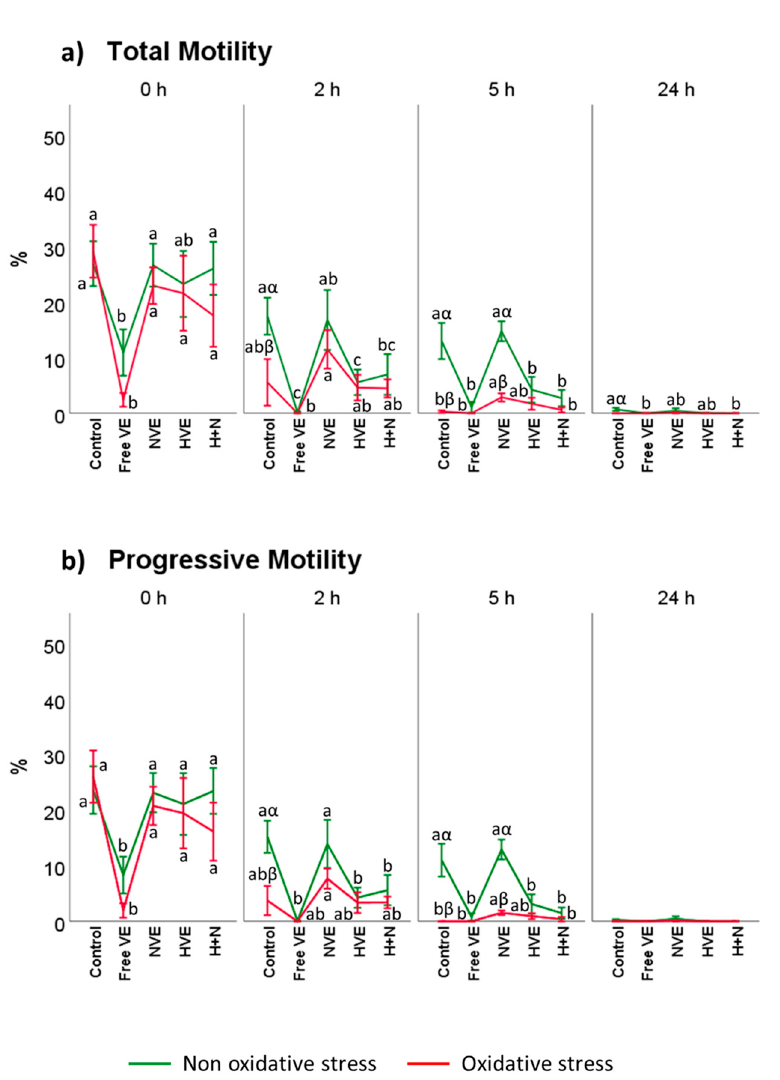
Figure 4. Vitamin E formulation effects on total ( a ) and progressive sperm motility ( b ). Plots represent the triple interaction of different vitamin E treatments × oxidative treatment × incubation time for CASA-derived variables. The various lowercase Latin letters ( p < 0.05) indicate significant differences between vitamin E treatments, while the different Greek letters ( p < 0.05) compare each treatment at the same time with a different oxidative stress status.